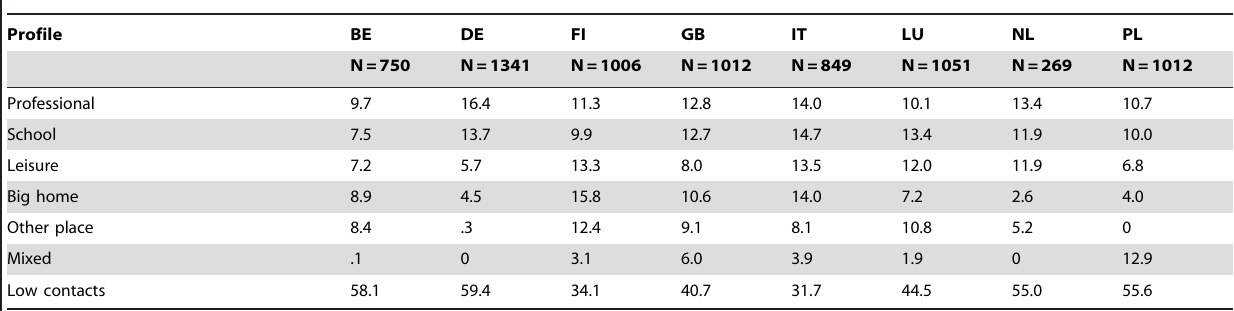
Table 3. Distribution of contact profiles across countries (%) *